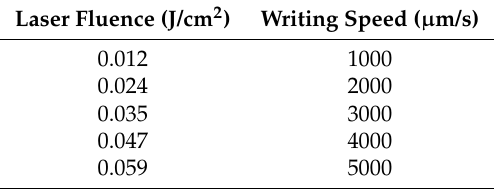
Table 2. Laser irradiation conditions at constant total irradiation